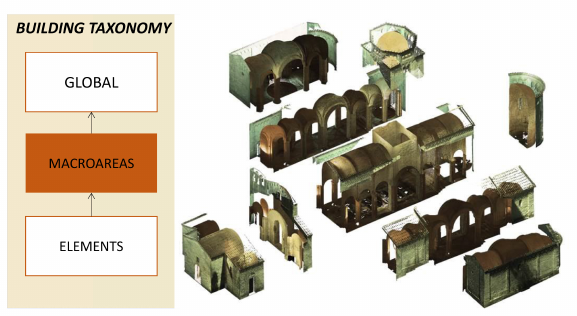
Figure 5. The building taxonomy at the intermediate level of macroareas. The ontology modelling follows the classical sub- division used in static analysis (macro-elements).